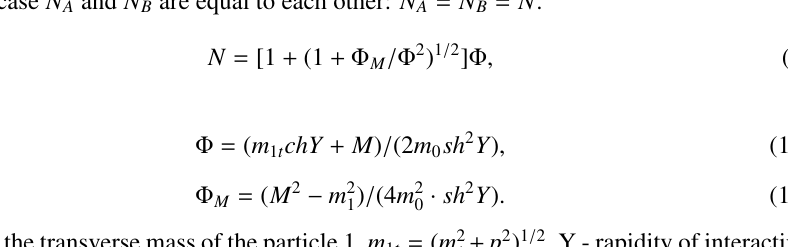
3 Self-similarity parameter in the central rapidity region In the mid-rapidity region ( y = 0, y is the rapidity of particle 1) the analytical form for Π was found in